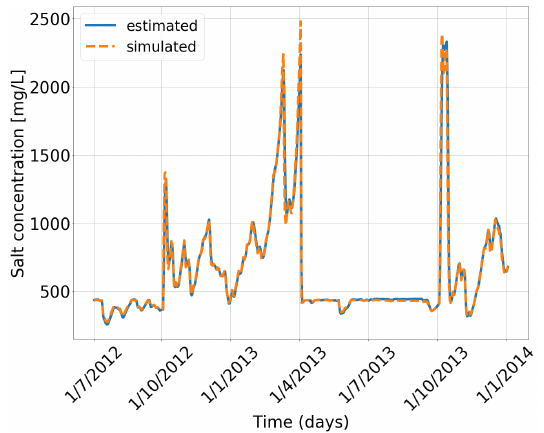
Figure 10. Performance of the sensor placement at node